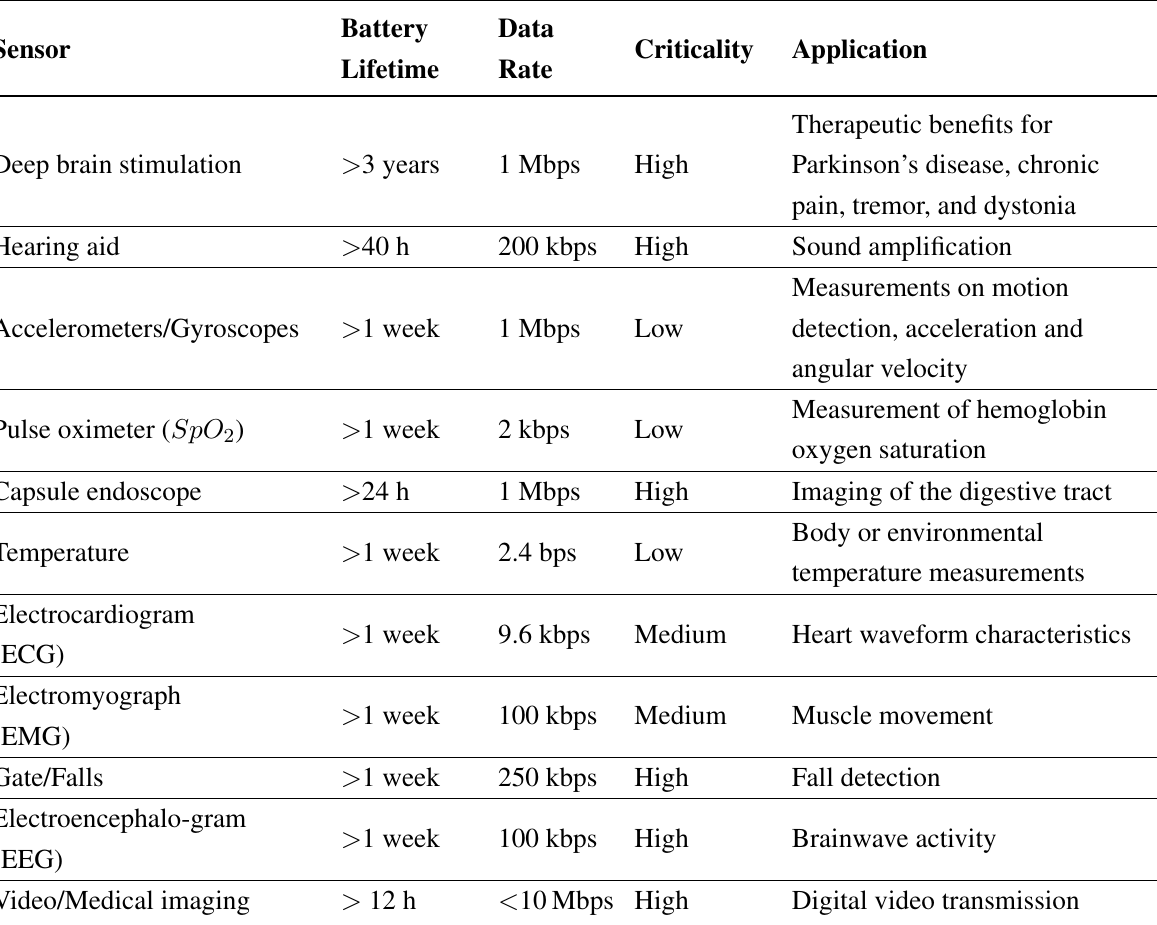
Technical characteristics of selected Wireless Body Area Networks (WBAN) sensors for mHealth applications